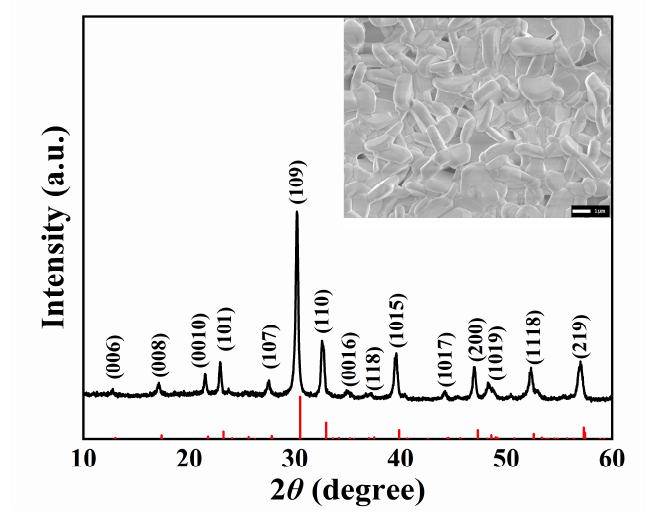
Figure 1. The XRD pattern and SEM image (embedded) of the NBT-Nb-Mn samples.